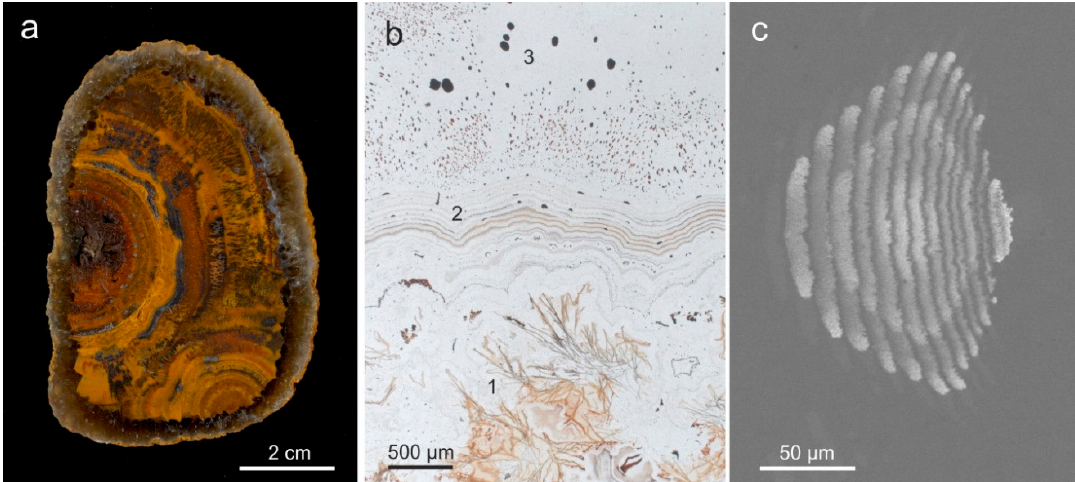
Figure 22. Fe ‐ oxides/hydroxides in agates: ( a ) “agate” from Xuanhua, province Hebei (China) almost completely consisting of Fe ‐ oxides/ ‐ hydroxides (hematite, goethite) showing a spherulitic growth; ( b ) micrograph in transmitted light of an agate from Xuanhua, province Hebei (China) showing the silica matrix with the distribution of Fe ‐ oxides/ ‐ hydroxides: dentritic (1), aligned along the chalcedony banding (2) and large, irregular particles (3); ( c ) SEM ‐ BSE image showing details of the micro ‐ texture of Fe ‐ oxides/ ‐ hydroxides in an agate from St. Egidien, Saxony (Germany), which follows the micro ‐ texture of the calcedony banding indicating simultaneous crystallization.